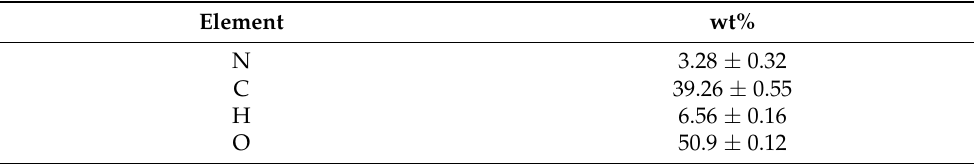
Table 1. Elemental analysis of PPoly.